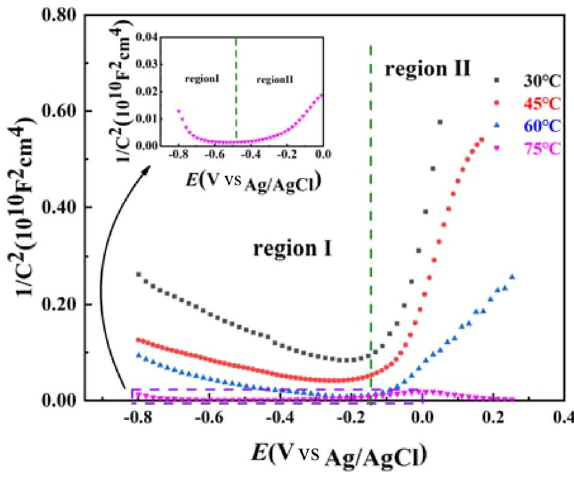
Figure 6. Mott-Schottky curve of 2205 DSS after polarization for 1 h.